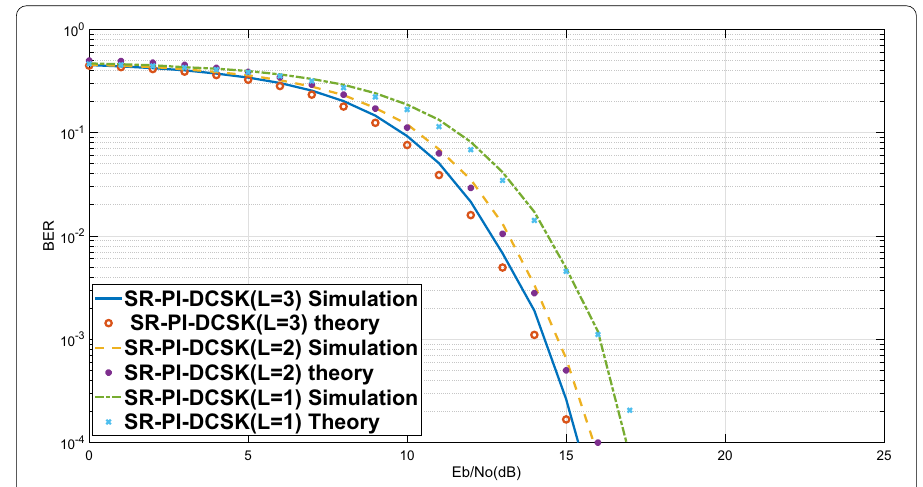
Fig. 12 Theoretical and simulation bit error performance for SR‑PI‑DCSK for different frame lengths for β = 100 . Simulation results are depicted by lines while theoretical results are depicted by markers